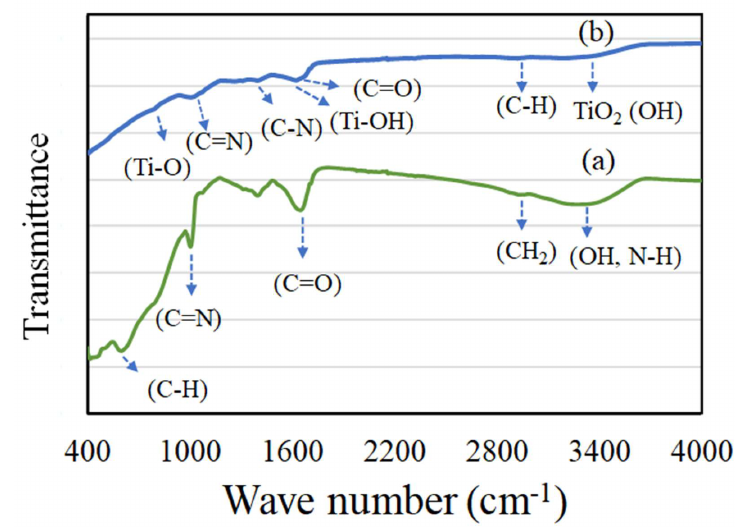
Figure 4. Fourier transform infrared (FT-IR) spectra of (a) Ag NPs and (b) TiO 2 NPs. The spectra (a) and (b) shows the presence of various phytocomponents related to amino, methyl and hydroxyl groups assist in Ag and TiO2 NPs formation.